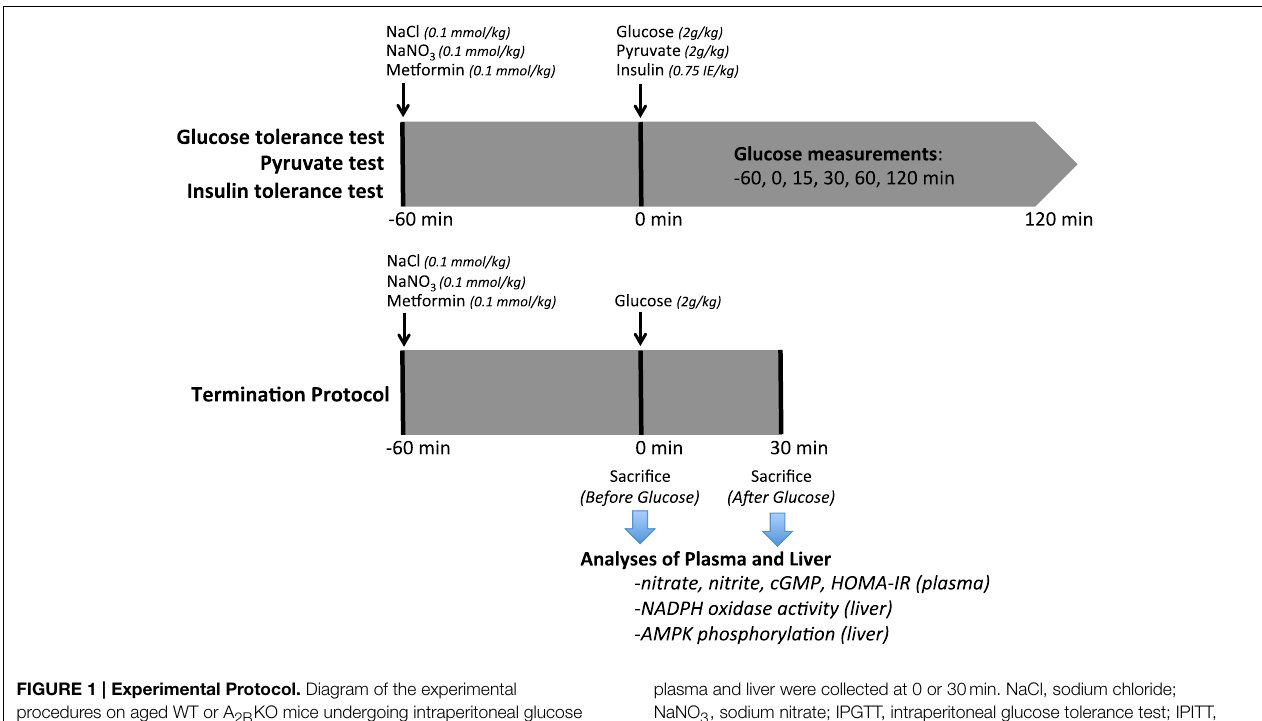
plasma and liver were collected at 0 or 30min. NaCl, sodium chloride; NaNO 3 , sodium nitrate; IPGTT, intraperitoneal glucose tolerance test; IPITT, intraperitoneal insulin tolerance